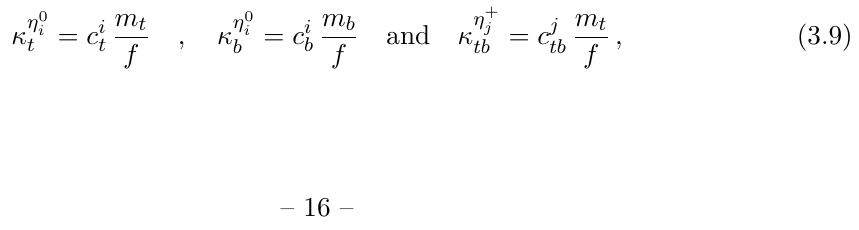
(c) Decays of η 0 for m 5 (cid:29) m 1 > m 3 = 600 GeV (d) Decays of η 0 3